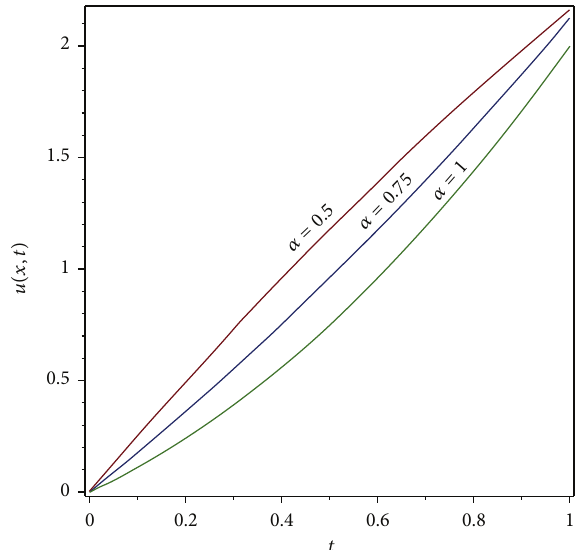
Figure 8: Plot of 𝑢(𝑥,𝑡) for various values of 𝑡 and different values of 𝛼 , 𝑥 = 1